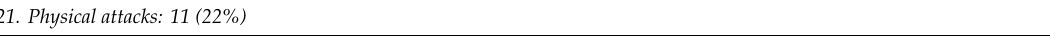
Category / Code: Frequency (Percentage) of Victim Responses. Exemplar